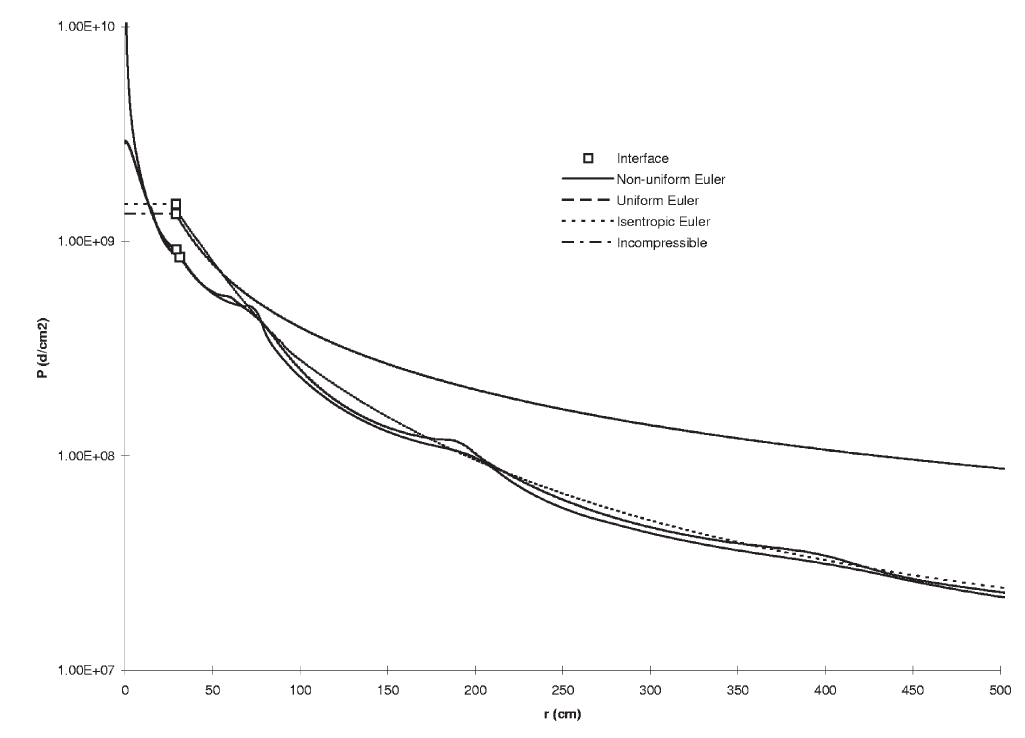
Fig. 9. Comparison of collapse pressure